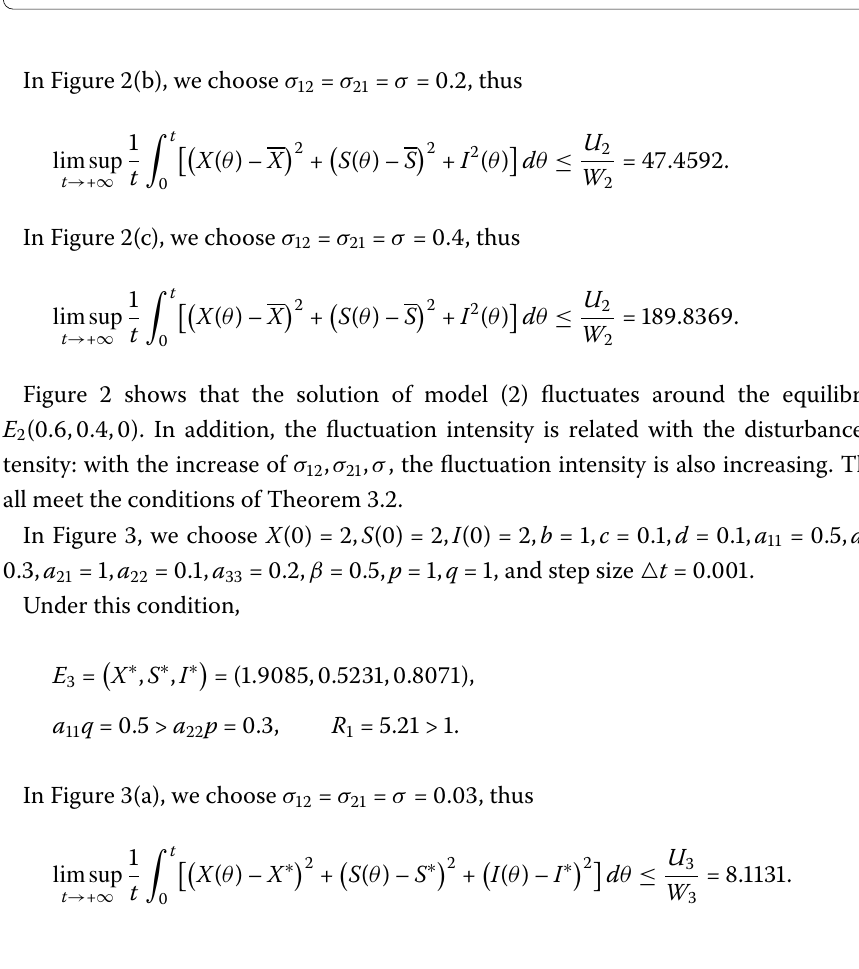
Figure 2 Time sequence diagram and phase portrait of model (2). (a) - (c) are a Brownian motion model with σ 12 = σ 21 = σ = 0.1,0.2,0.4, respectively. (d) - (f) are phase portraits of (a) - (c) , respectively. The red ◦ is corresponding to the deterministic model, while the blue ◦ represents the stochastic